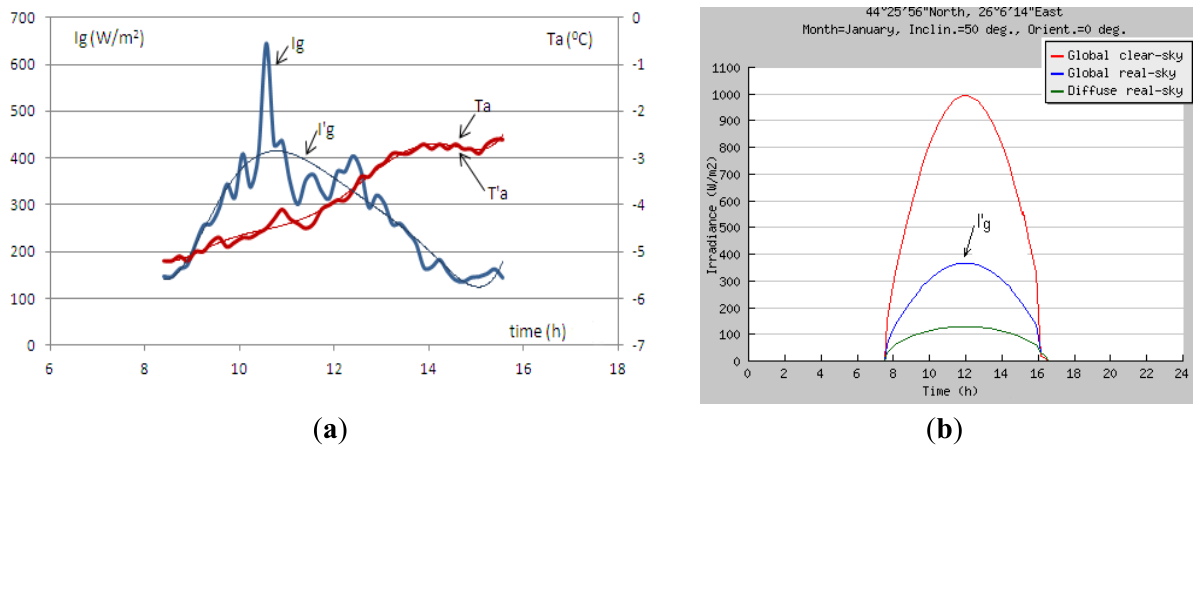
Figure 1. Global solar irradiance on a tilted plane for a clean sky day from January 2009: ( a ) Proprietery software, T ’ and I ’ are interpolated values with sixth degree polynomials; a g ( b ) JRC PVGIS